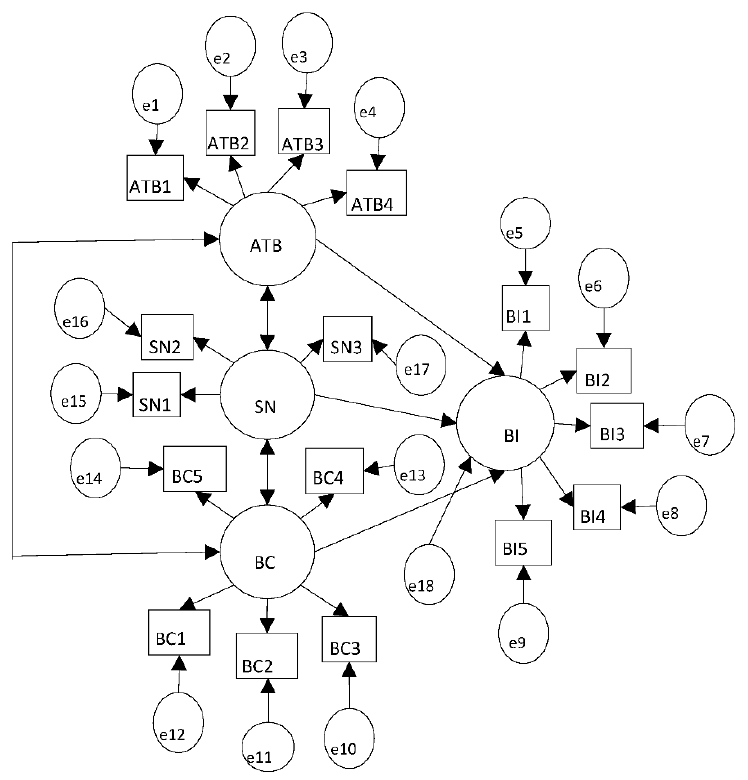
Figure 1. Model proposed in the study.